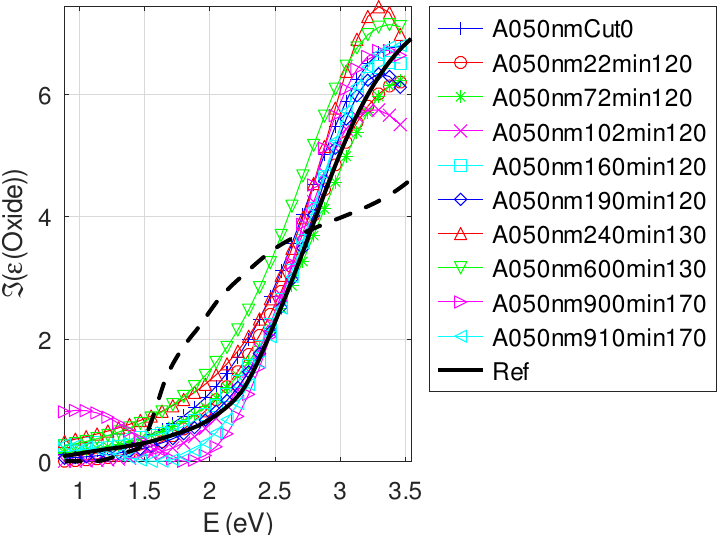
Figure A15. Imaginary part of the relative permittivity of oxide as a function of the photon energy: bulk Cu 2 O (black solid line), bulk CuO (black dashed line) and best calculated (color) for each = 50 oxidized sample (initial thickness h 0 Cu